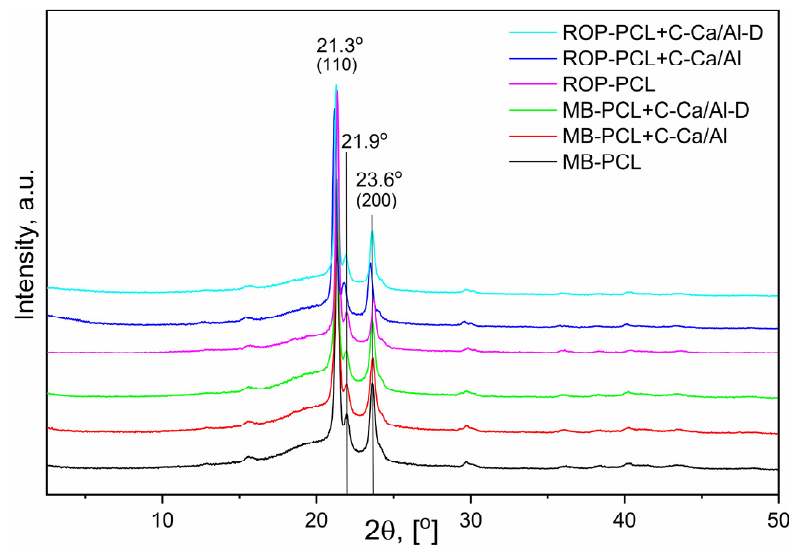
Figure 3. XRD patterns of prepared PCL-LDH nanocomposites.